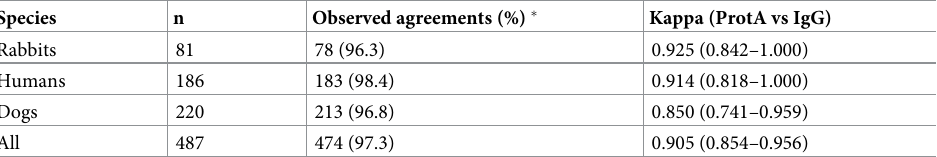
Table 2. Kappa agreement test between Protein A-ELISA and Anti-IgG